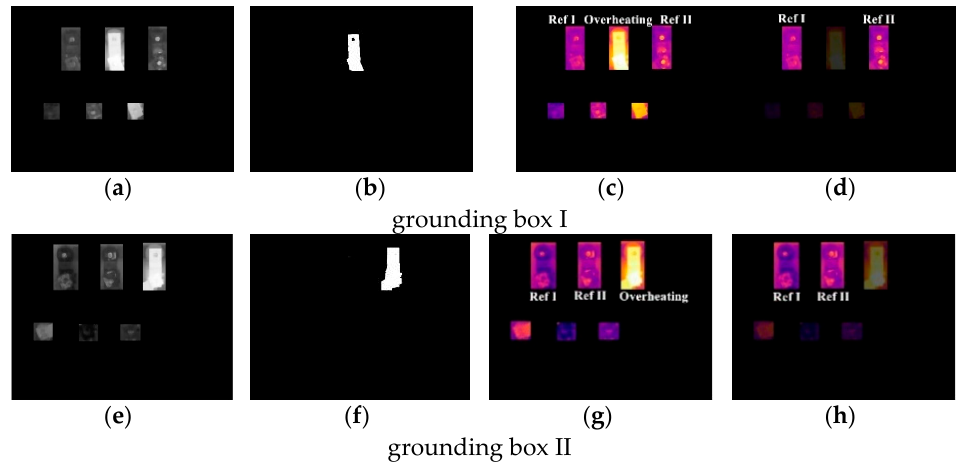
Figure 12. Reference regions locating results of grounding boxes: ( a ) & (e) grayscale image, ( b ) & (f) extracting results of suspected overheating regions, ( c ) & (g) suspected overheating phase and reference phases, ( d ) & (h) locating results of reference regions.